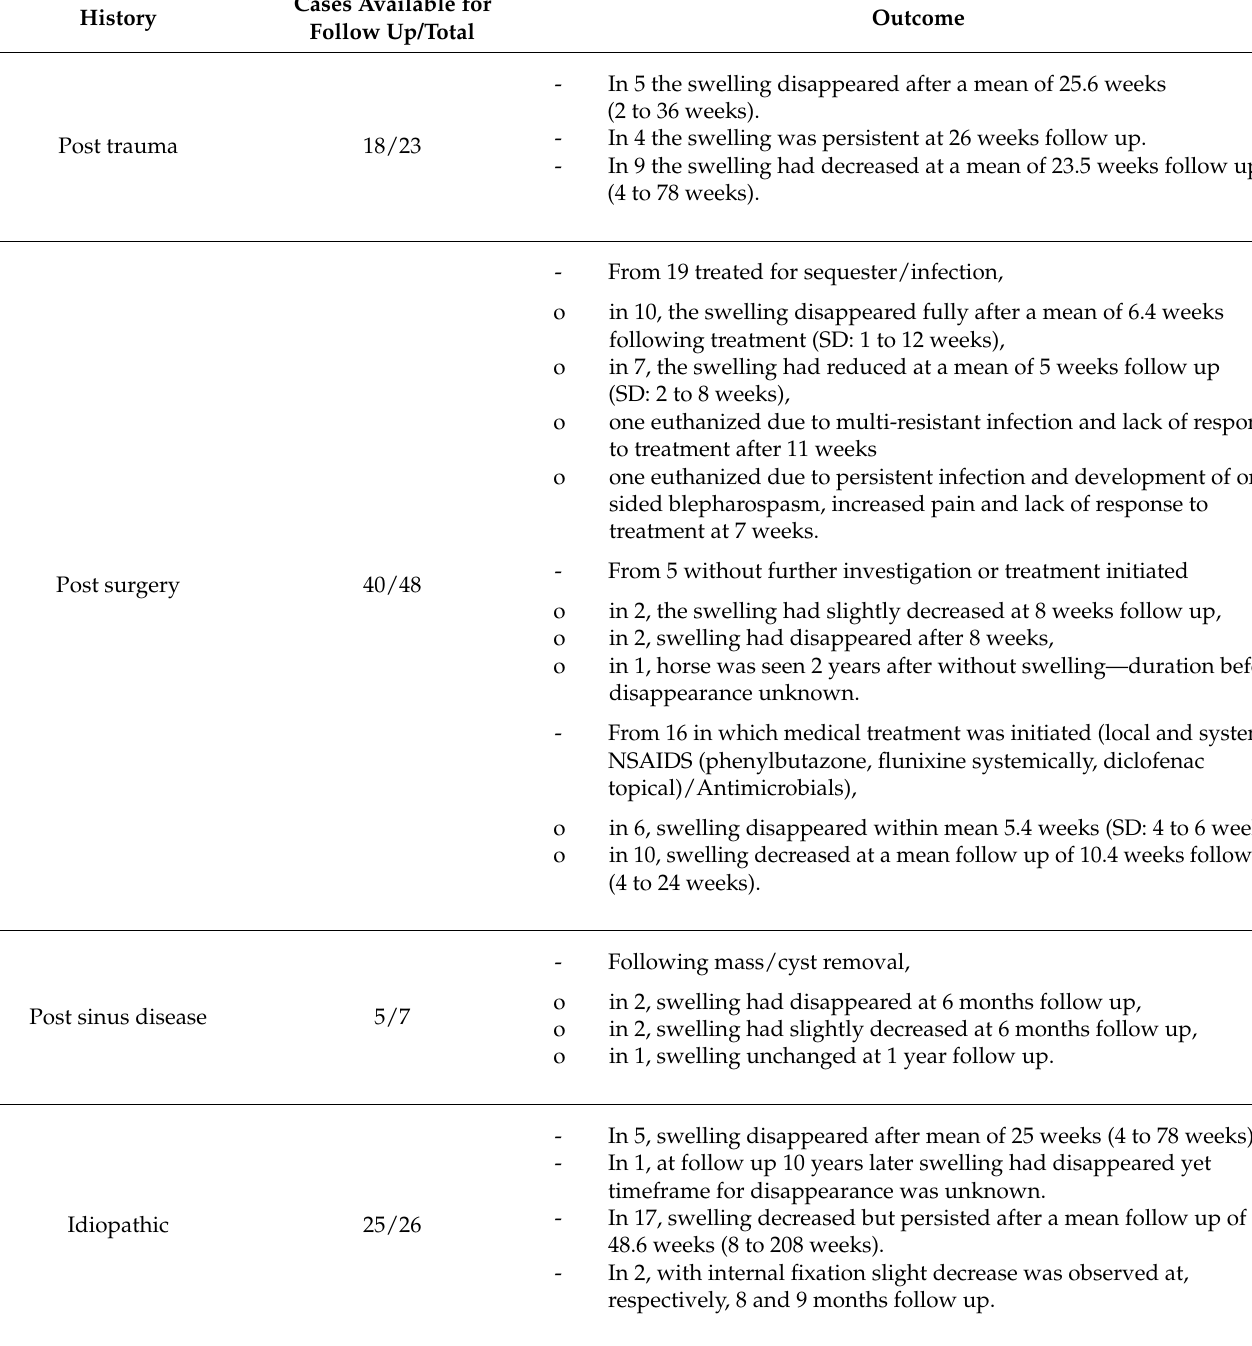
Table 7. Follow up information in 88 equine cases with suture exostosis divided according to history of